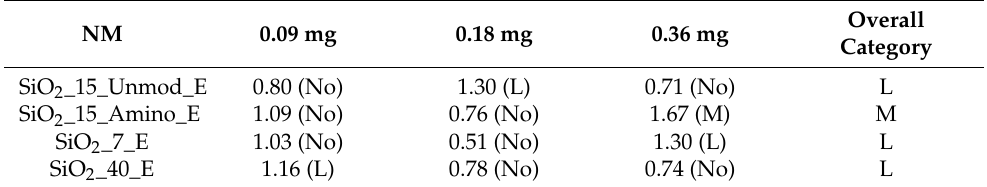
Table 3. Protein carbonylation (values are fold changes relative to control) in rat lung following NM instillation.